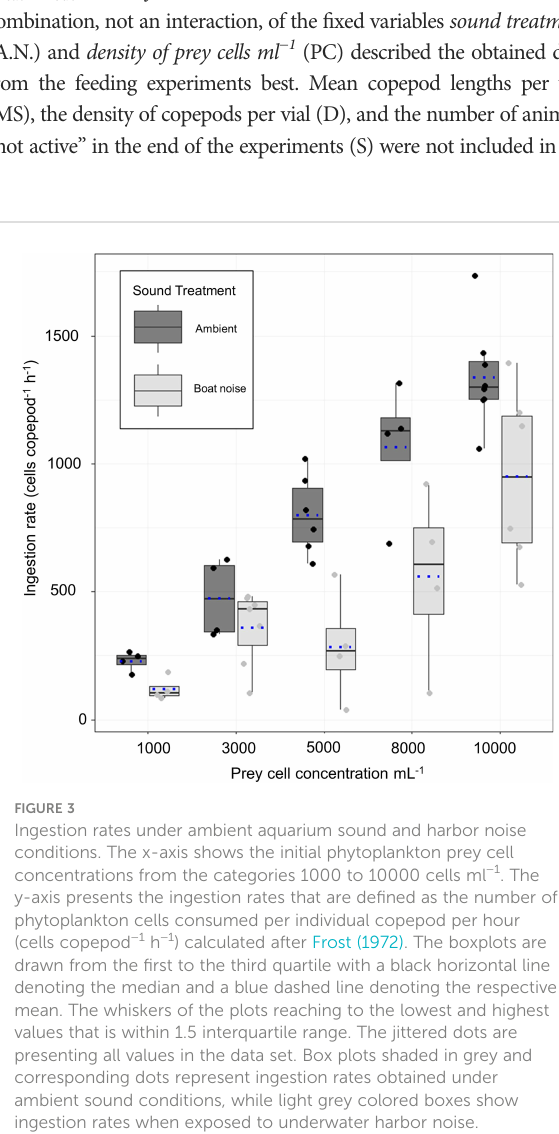
(A.N.) and density of prey cells ml − 1 (PC) described the obtained data from the feeding experiments best. Mean copepod lengths per vial (MS), the density of copepods per vial (D), and the number of animals “ not active ” in the end of the experiments (S) were not included in the